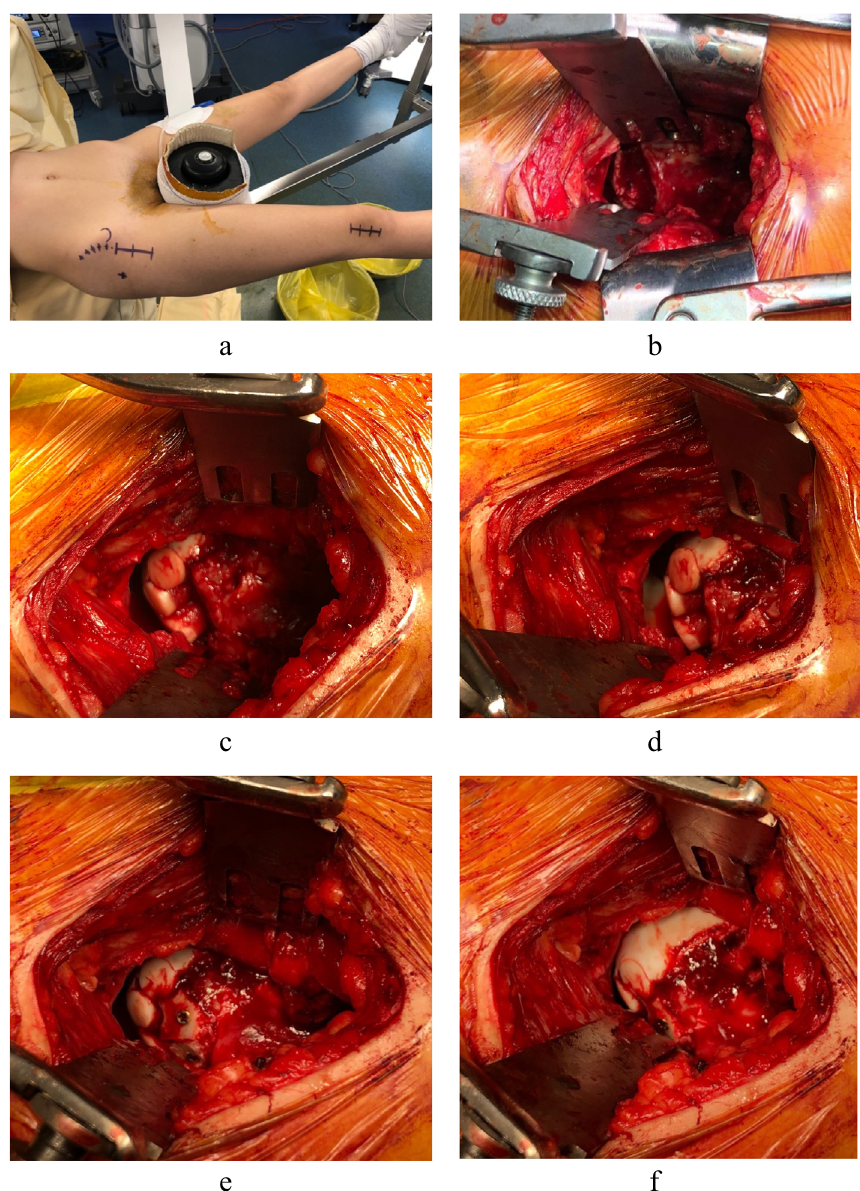
Figure 2. Intra-operative images of the right hip, demonstrating patient positioning (a), osteochondral lesion of the femoral head (b), femoral head after insertion of three osteochondral plugs (c, d), and fi lling of the non-weight-bearing surface with a screwed iliac crest autograft (e,